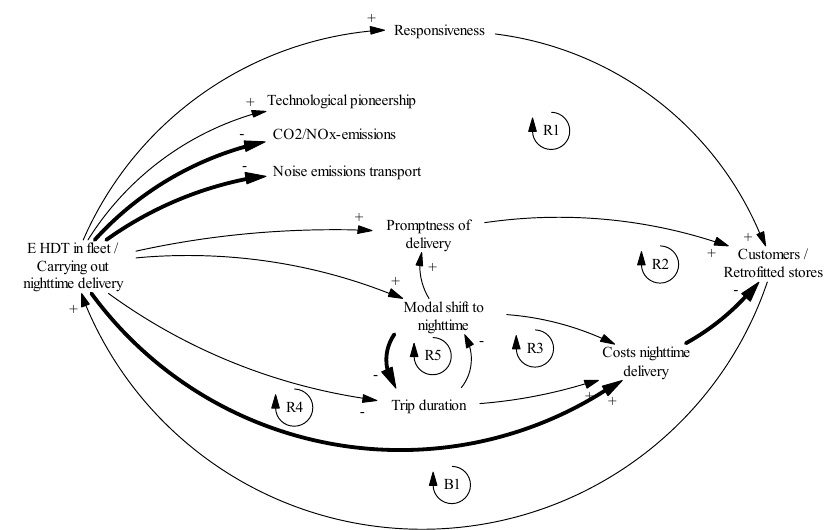
Figure 1. Causal loop diagram resulting from the CIA.